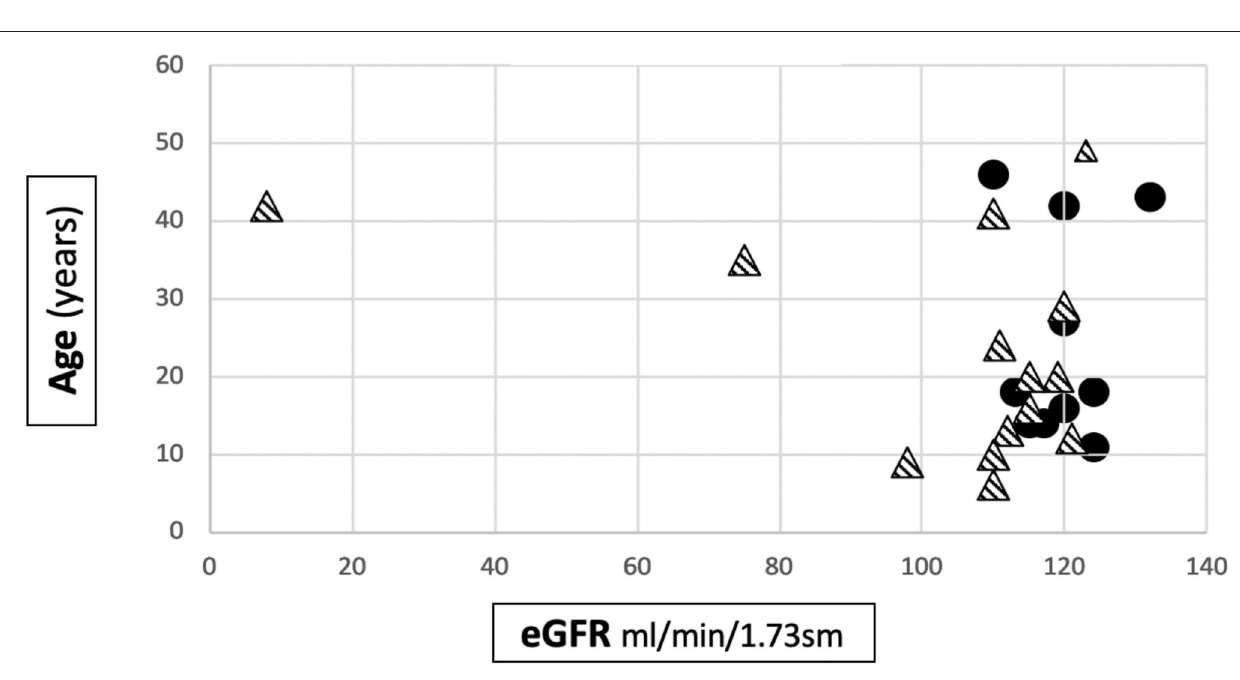
sharing the same mutation, in which the inactivation of X must always be taken into account